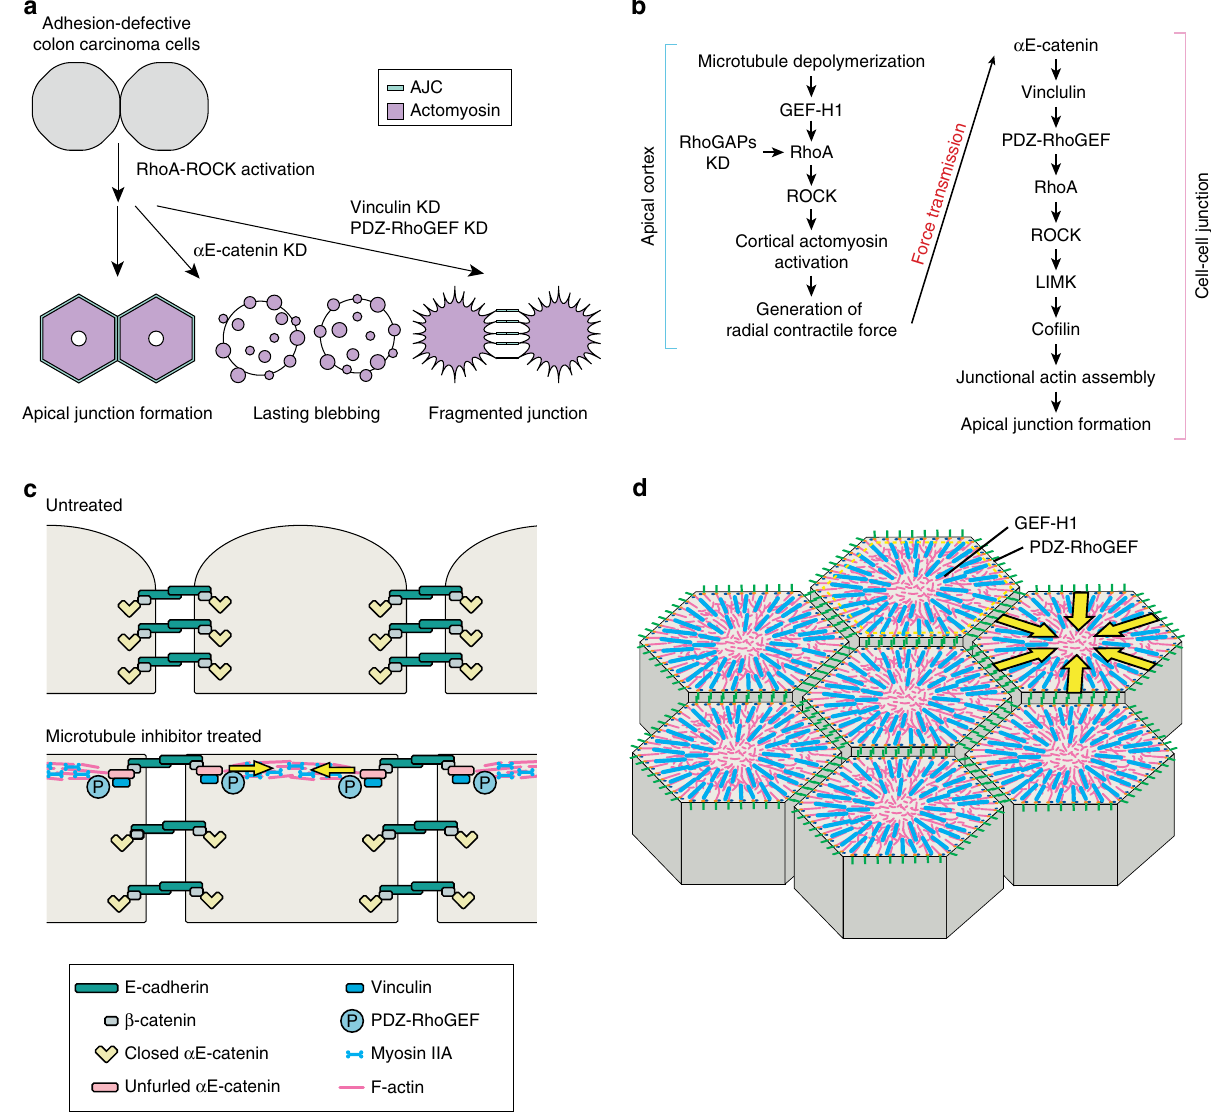
Fig. 9 Summary and models. a Responses of HT29 cells to various treatments. b Molecular pathways for AJC induction in HT29 cells. c , d Molecular events enabling AJCs restoration in adhesion-defective colon carcinoma